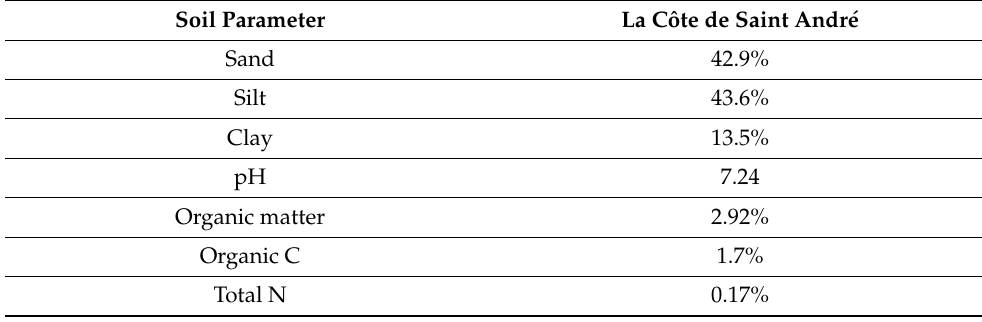
Table 2. Physical characterization of La C ô te de Saint Andr é soil (France). Soil